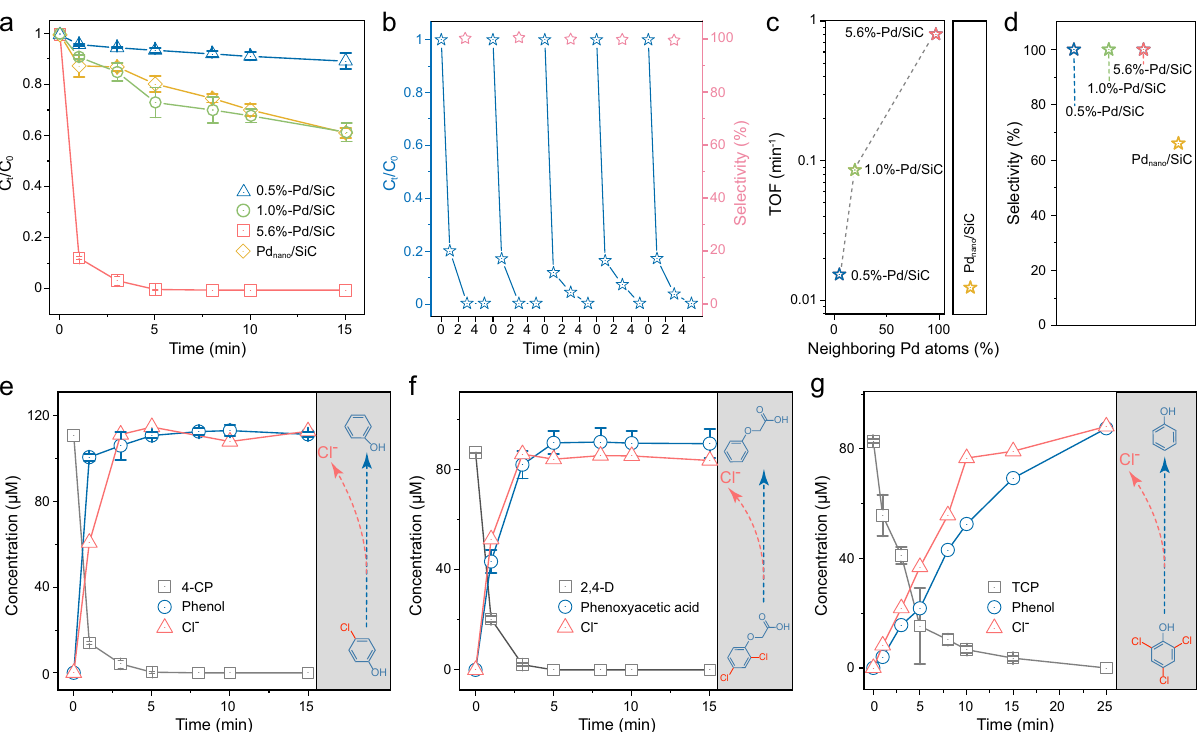
Fig. 2 Catalytic performance of Pd/SiC in the hydrodehalogenation of organohalides. a Hydrodehalogenation kinetics of 4-CP by Pd/SiC. b Conversion ratio and selectivity of 4-CP at 5min by 5.6%-Pd/SiC over fi ve consecutive cycles. c TOF per Pd atom basis calculated with the initial zero-order rate constant of 4-CP hydrogenation. d Selectivity of hydrodehalogenation. e – g Kinetic plots of the organohalide hydrogenation and product generation. The Cl − concentrations in f and g were divided by a factor of two (i.e., each 2,4-D molecule contains two Cl atoms) or three (i.e., each TCP molecule contains three Cl atoms) to visualize the comparisons. Experimental conditions: catalyst (0.5gL − 1 ), H 2 (1atm), room temperature (20°C). Error bars represent standard deviations from triplicate